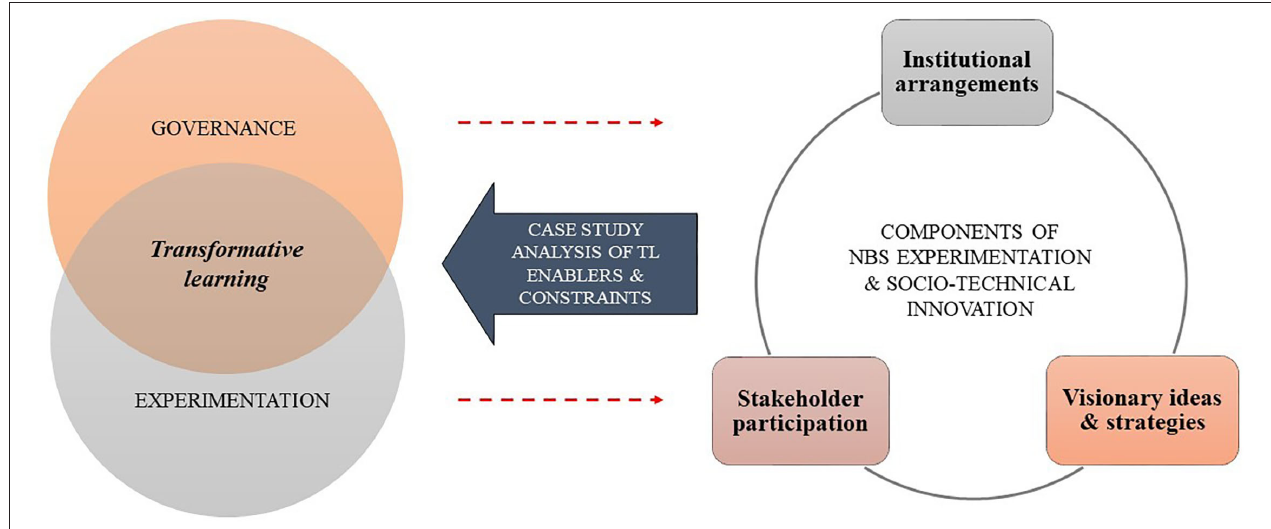
FIGURE 1 | Framework to analyse conditions and activities which enable and constrain transformative learning in processes of NBS implementation.